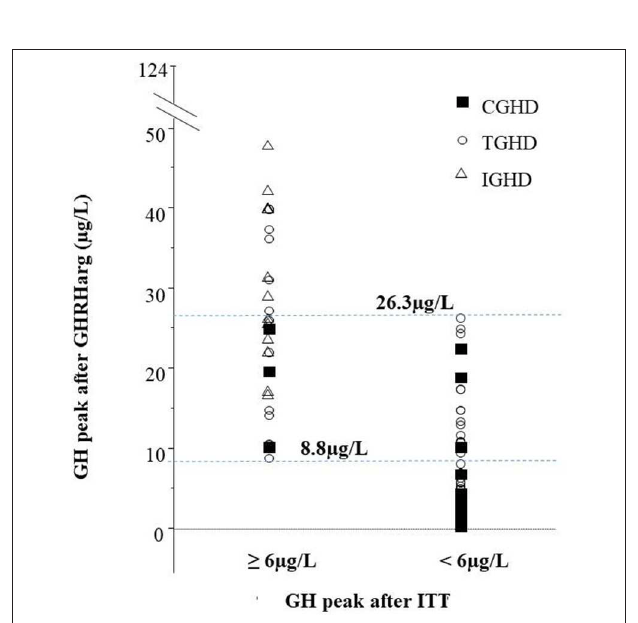
FIGURE 2 | GH peak to GHRHarg in the cohort based on the GH response to ITT ≥ 6 µ g/L or < 6 µ g/L. The peak GH to GHRHarg values between 8.8 µ g/L (lowest peak in subjects with GH ≥ 6 µ g/L) and 26.3 µ g/L (highest peak in patients with GH < 6 µ g/L) are represented; 29 subjects with idiopathic GHD (open triangles), 15 with congenital GHD (closed squares), and 44 Tumoral GHD (open circles).